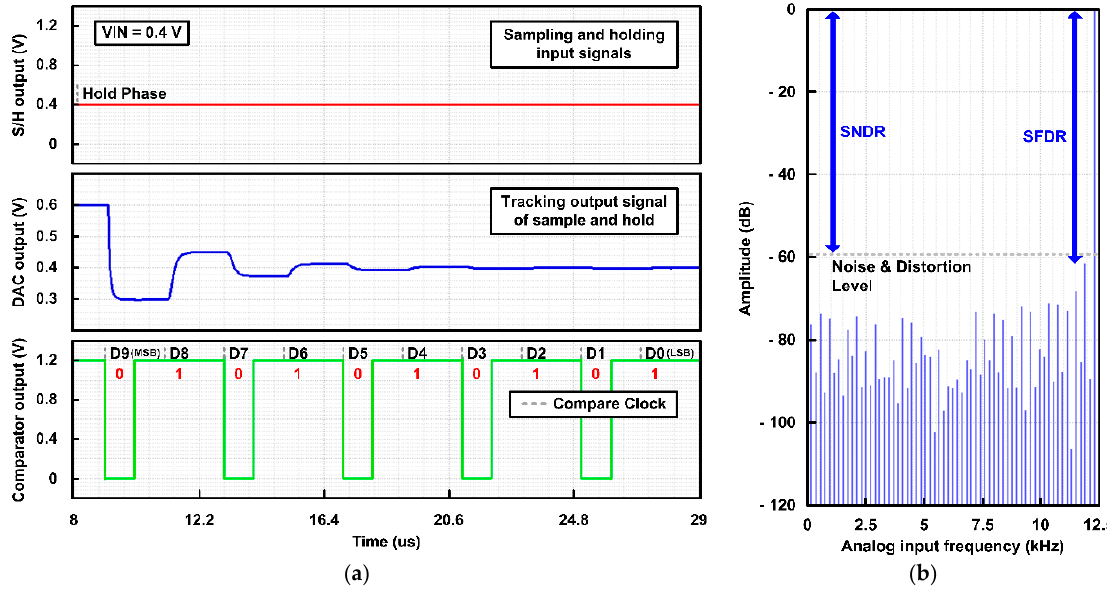
Figure 16. ( a ) Simulated waveforms of each component in the SAR ADC (sample-and-hold circuit (S/H), digital-to-analog converter (DAC), and comparator) and ( b ) simulated 128-point FFT spectrum at 25 kS/s.